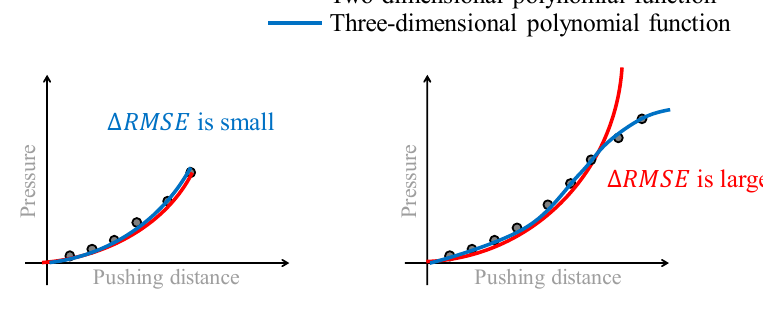
Figure 7. CP detection method.